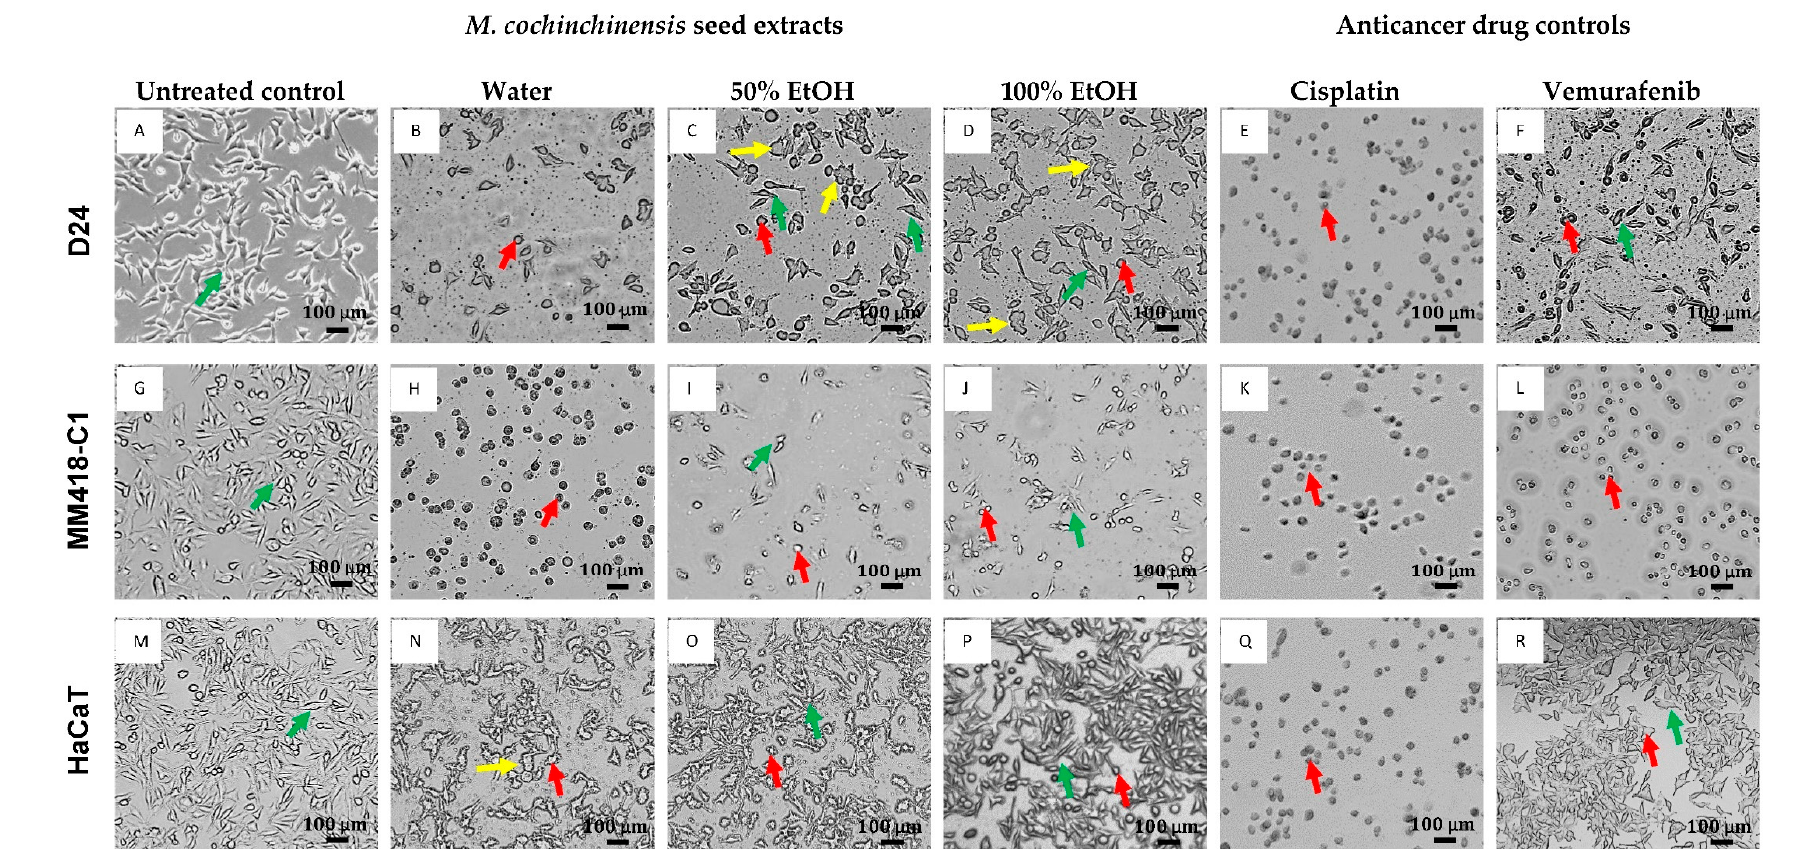
Figure 2. Effect of 48 h exposure to 100 µg/mL M. cochinchinensis seed extracts on melanoma (D24 and MM418-C1) and HaCaT cells compared to cisplatin and vemurafenib treatment. Green arrows indicate normal cells, red arrows indicate cell shrinkage, yellow arrows indicate cell swelling (Scale bar = 100 µm). ( A ): Untreated D24 cells (control), ( B ): D24 cells treated with water extract, ( C ): D24 cells treated with 50% EtOH extract, ( D ): D24 cells treated with 100% EtOH extract, ( E ): D24 cells treated with cisplatin, ( F ): D24 cells treated with vemurafenib, ( G ): Untreated MM418-C1 cells (control), ( H ): MM418-C1 cells treated with water extract, ( I ): MM418-C1 cells treated with 50% EtOH extract, ( J ): MM418-C1 cells treated with 100% EtOH extract, ( K ): MM418-C1 cells treated with cisplatin, ( L ): MM418-C1 cells treated with vemurafenib, ( M ): Untreated HaCaT cells (control), ( N ): HaCaT cells treated with water extract, ( O ): HaCaT cells treated with 50% EtOH extract, ( P ): HaCaT cells treated with 100% EtOH extract, ( Q ): HaCaT cells treated with cisplatin, ( R ): HaCaT cells treated with